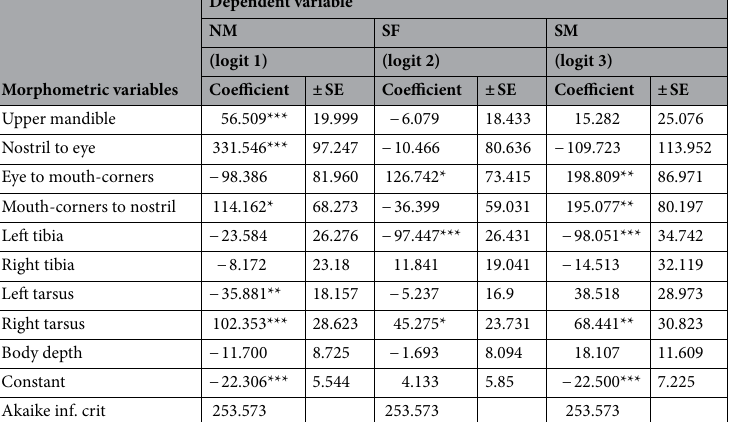
Table 3. Multinomial logistic regression model shows the morphological variables associated with different populations of Painted Storks among sexes and regions, with the north female (NF) Painted Stork as